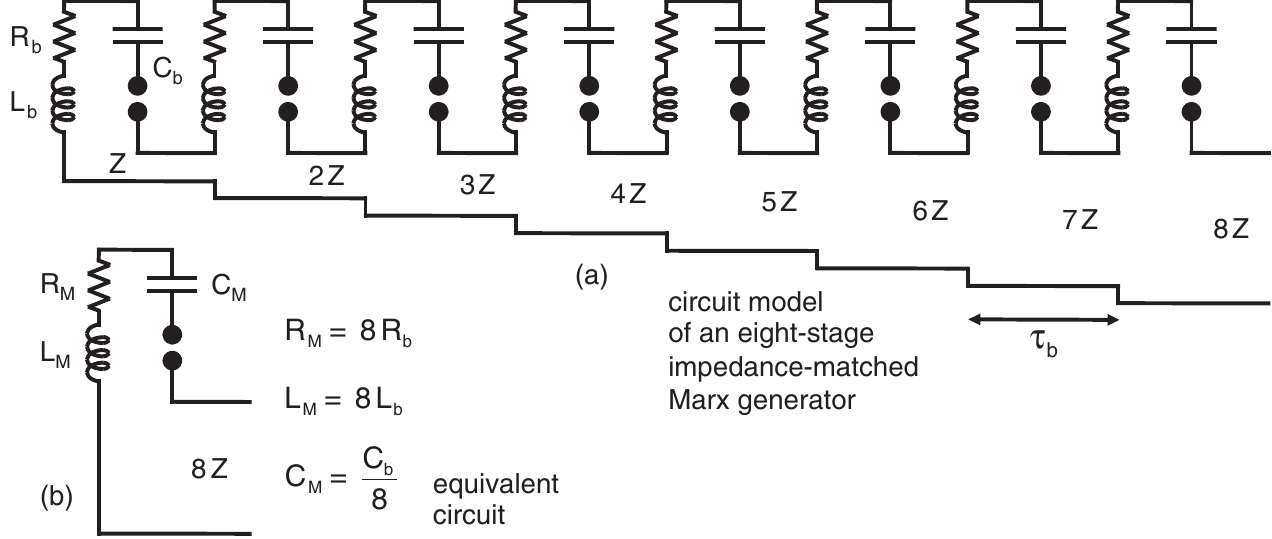
FIG. 6. (a) Circuit model of an impedance-matched Marx generator. (b) Equivalent circuit of such a Marx, when each brick of the circuit is triggered at time τ after the brick immediately upstream is triggered. The quantity τ b transmission-line segment that connects two adjacent